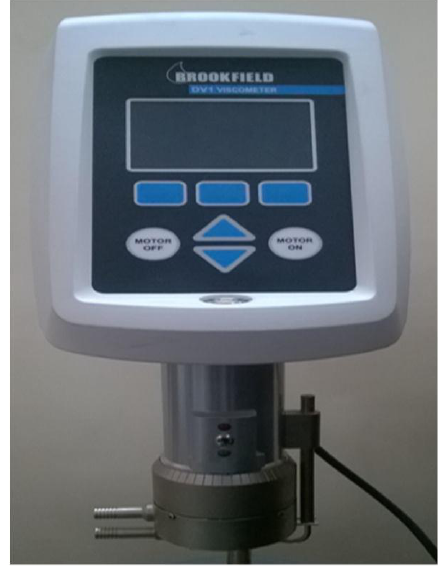
Figure 4. Brookfield digital viscometer.